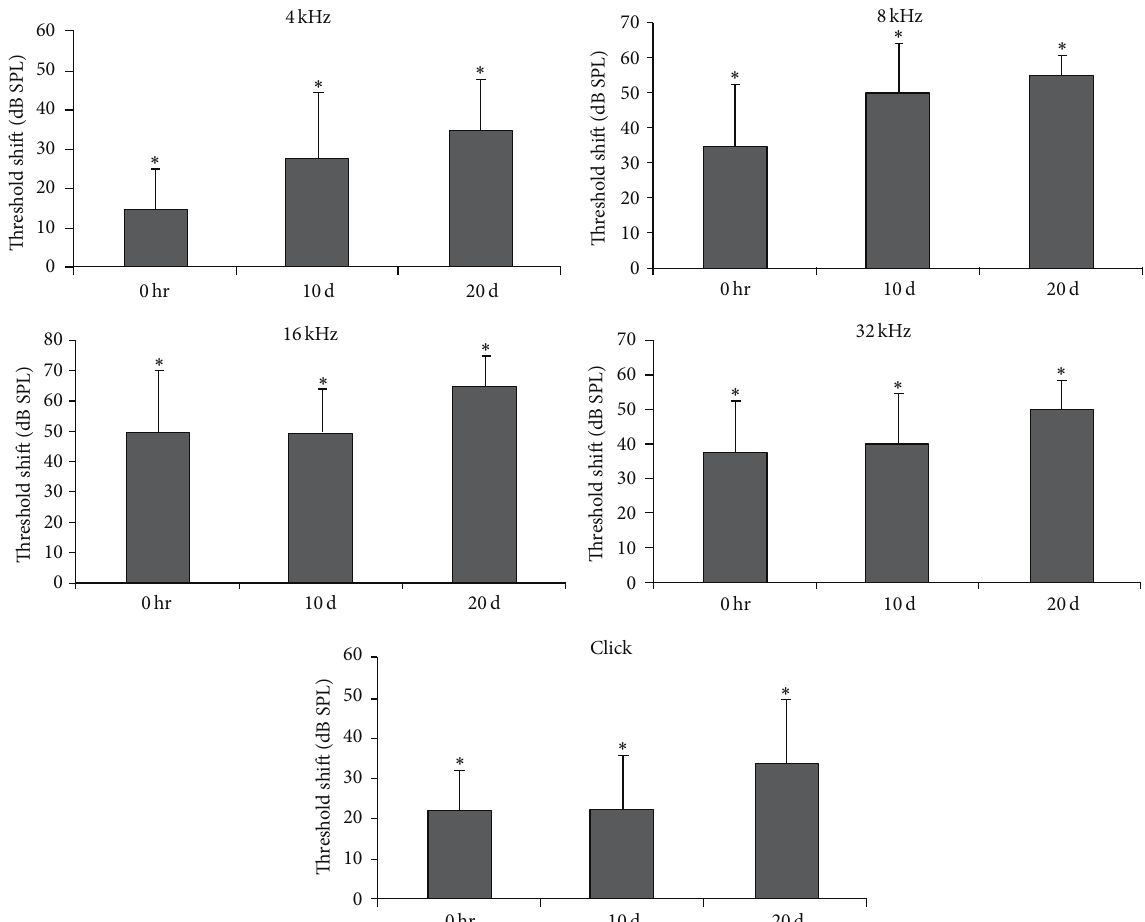
Figure 2: ABR threshold shifts immediately after surgery and at 10 and 20 days postoperatively. Increased ABR threshold shifts were sustained until 20 days after surgery at all measured frequencies. ∗ 𝑝 < 0.05